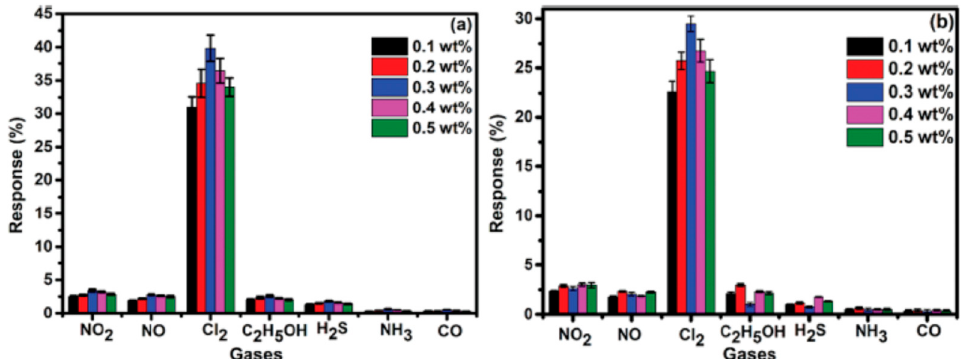
Figure 12. Selectivity histogram of CoPcF 16 /SWCNTs–COOH ( a ) and ZnPcF 16 /SWCNTs–COOH ( b ) hybrids for 500 ppb of NO 2 , NO, Cl 2 , C 2 H 5 OH, H 2 S, NH 3 and CO at room temperature [88].